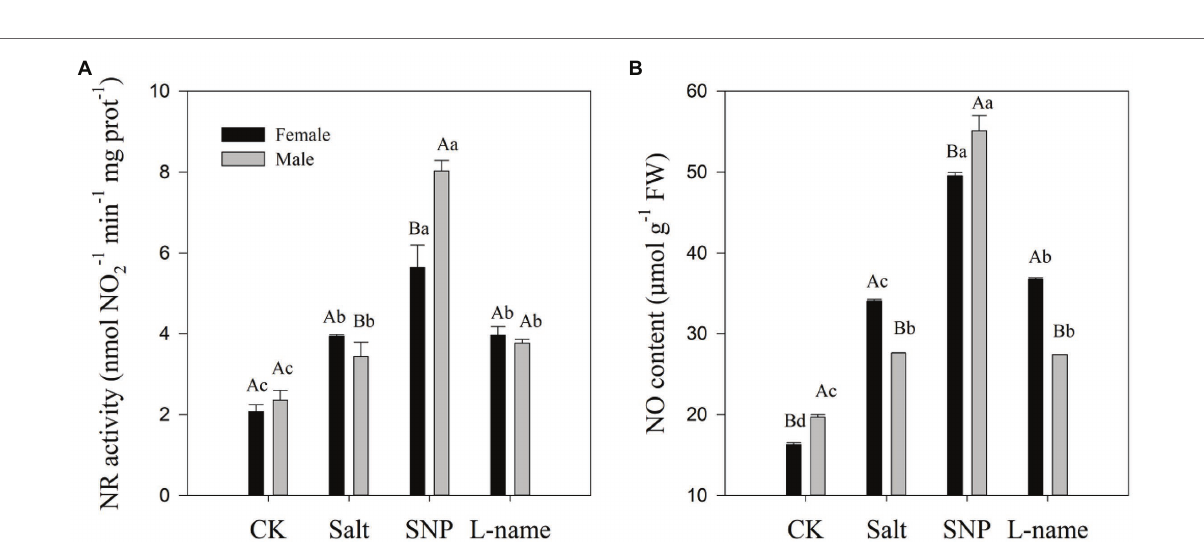
FIGURE 5 | Nitrate reductase (NR) activity (A) and NO content (B) of T. grandis in response to different treatments. CK (control, distilled water), salt (100 mM NaCl), SNP (100 mM NaCl with 0.05 mM SNP), and L-name (100 mM NaCl with 0.5 mM SNP and L-name). Different uppercase letters indicate a significant difference between different genders at p < 0.05, and different lowercase letters indicate significant difference under salt treatment at p < 0.05, according to Duncan’s